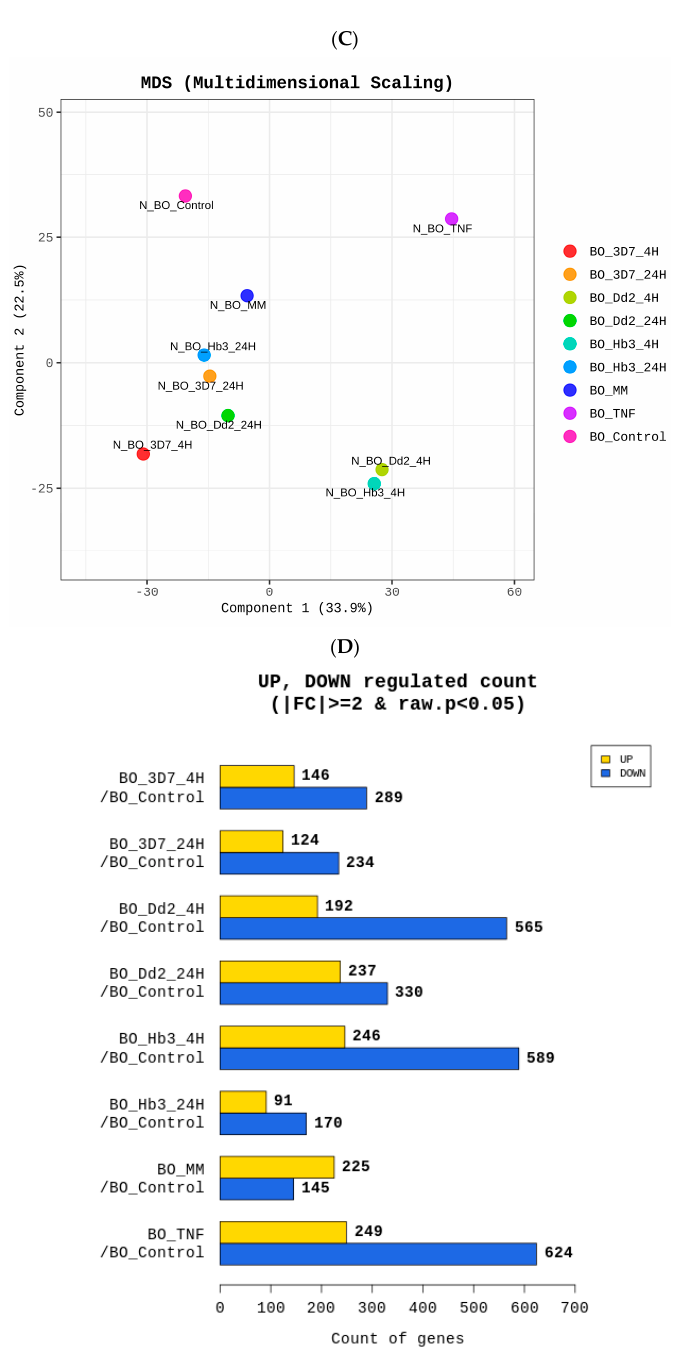
Figure 4. Data quality and data analysis of cerebral organoids transcriptome. ( A ) Reproducibility between total samples: The similarity between samples obtained through Pearson’s coefficient of the sample’s normalized value, for range: − 1 ≤ r ≤ 1. ( B ) Heatmap for DEG-Hierarchical Clustering: Clusters the similarity of genes and samples by expression level using Z-score for normalized value (log2 based). A total of 2045 genes satisfy |F| ≥ 2 and p -value ( p < 0.05) from the significant list. Each column represents a condition. Genes down-regulated are in blue and up-regulated are in yellow. ( C ) Multidimensional Scaling Analysis: Using each sample’s normalized value, the similarity between samples is graphically shown in a 2D plot to show the variability of the total data. ( D ) Significant UP and DOWN count by fold change (|F| ≥ 2) and p -value ( p < 0.05) shows the number of up and down-regulated genes based on fold change of comparison